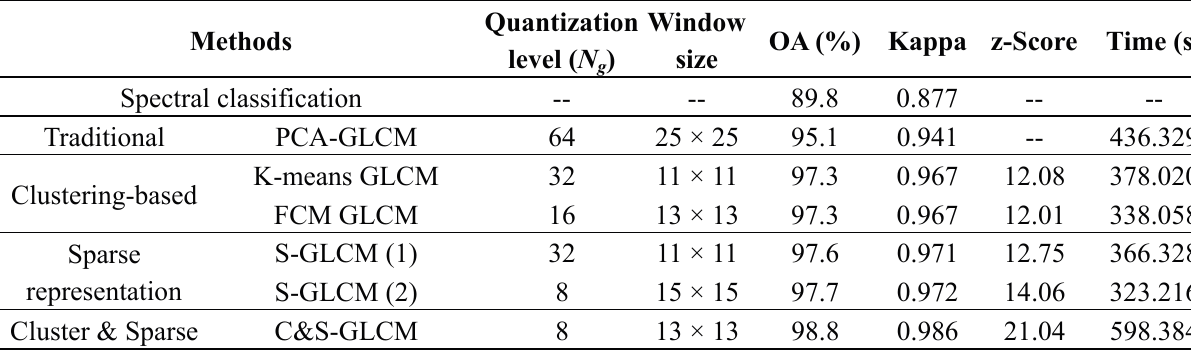
Table 13. The classification accuracies achieved by different texture extraction algorithms with the optimal parameters. The z-scores between the proposed methods and PCA-GLCM are also reported (HYDICE DC Mall